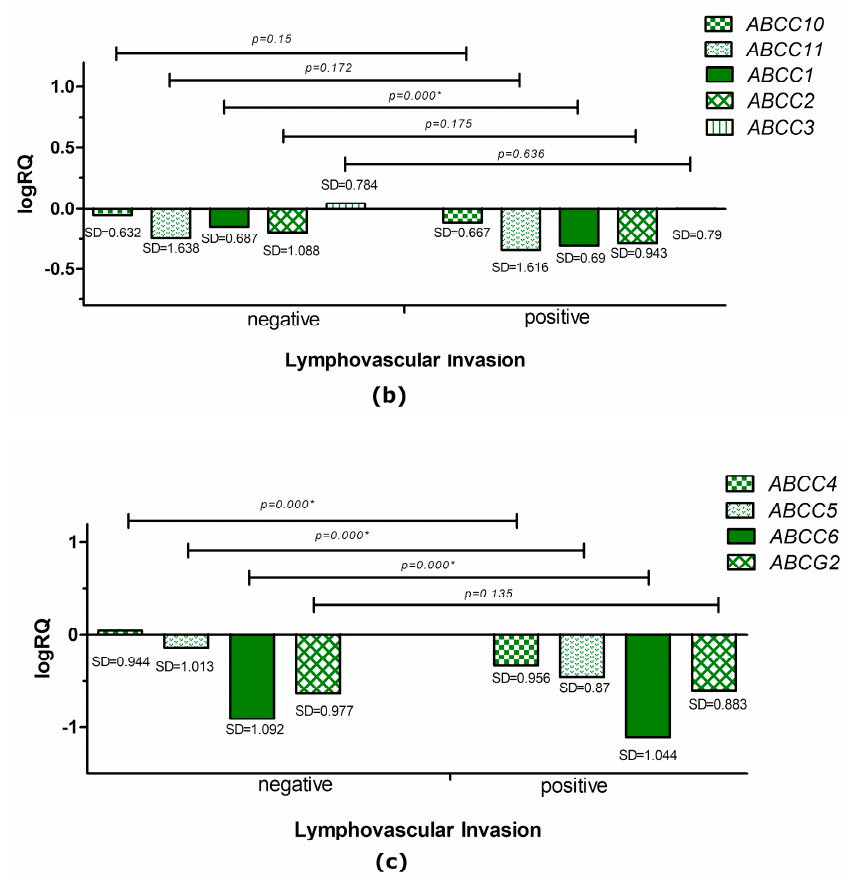
Figure 6. Mean expression level (logRQ) of the ABCA2 , ABCA3 , ABCB1 , ABCB4 , and ABCB9 genes ( a ); the ABCC10 , ABCC11 , ABCC1 , ABCC2 , and ABCC3 genes ( b ); and the ABCC4 , ABCC5 , ABCC6 , and ABCG2 genes ( c ) in triple-negative breast cancer tissue compared to tissue normal in groups based on the presence or absence of lymphovascular invasion. Statistically significant values are marked with